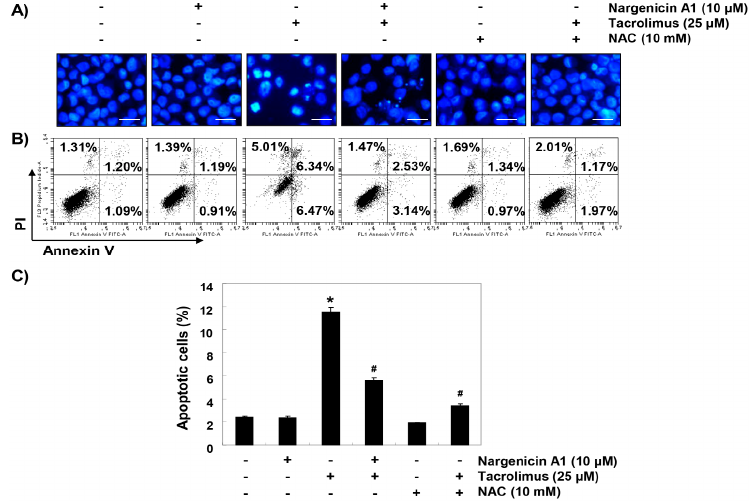
Figure 2. Suppression of tacrolimus-induced apoptosis by nargenicin A1 in HINAE cells. HINAE cells were treated with 10 μ M nargenicin A1 or 10 mM NAC for 1 h, and then stimulated with or without 25 μ M tacrolimus for 24 h. ( A ) Cells were collected, fixed, stained with 4,6-diamidino-2-phenylindole (DAPI), and photographed under a fluorescence microscope (original magnification, ×400). Scale bar, 50 μ m. ( B , C ) Cells cultured under the same conditions were collected and stained with fluorescein isothiocyanate (FITC)-conjugated Annexin V and propidium iodide (PI) for flow cytometry. ( B ) Results showed necrosis, defined as annexin V-negative and PI-positive cells (lower upper quadrant), early apoptosis, defined as annexin V-positive and PI-negative cells (lower right quadrant), and late apoptosis, defined as annexin V-positive and PI-positive (upper right quadrant) cells. ( C ) Percentages of apoptotic cells were determined by expressing numbers of Annexin V-positive cells as percentages of all cells present. Results are presented as the means ±